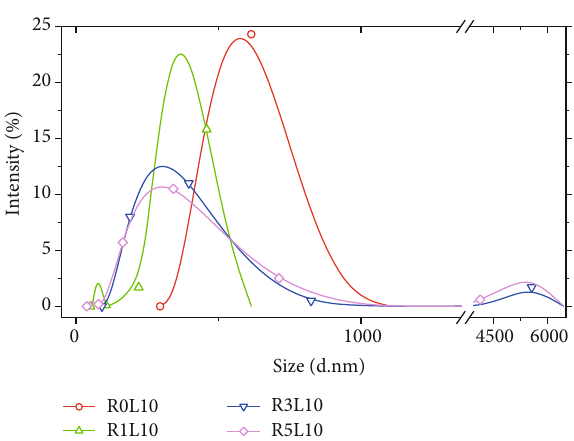
Figure 10: Particle size distribution diagram of NPB using 10wt.% Lov and di ff erent ginsenoside Rb1 content.